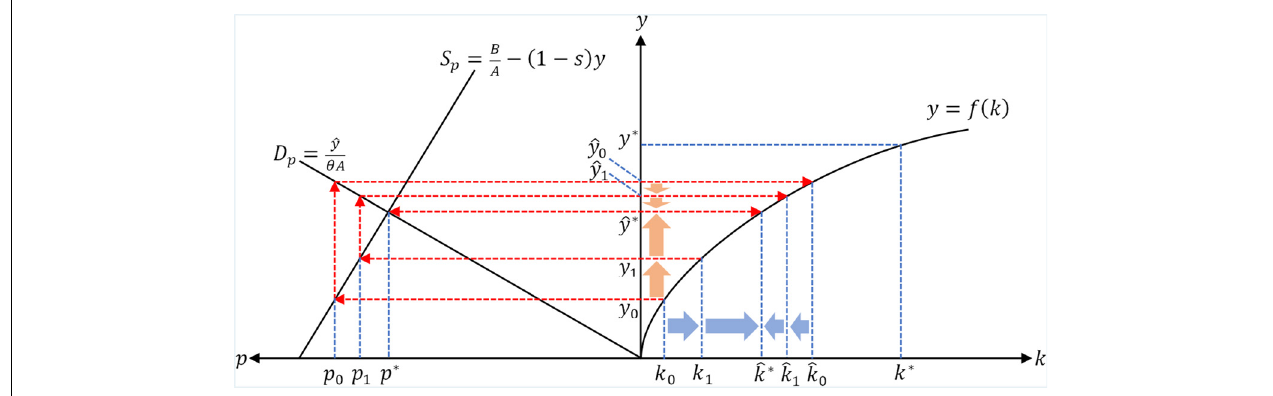
FIGURE 2 | Equilibrium in the emission quotas market.